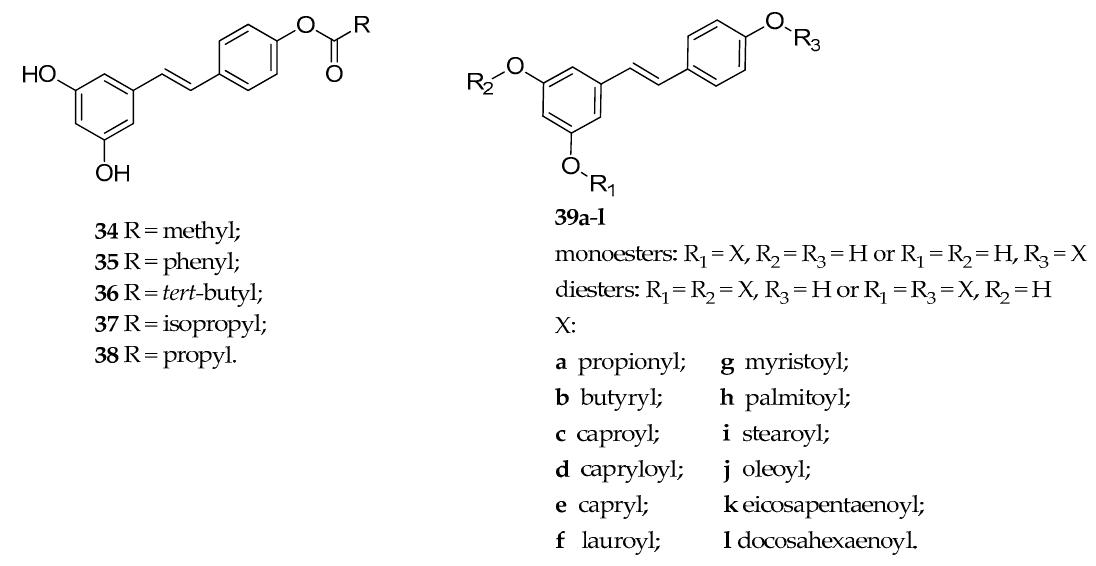
Figure 14. Chemical structures of 4’-RSV ester derivatives 34–38 , and mono and diester RSV derivatives 39a–l .